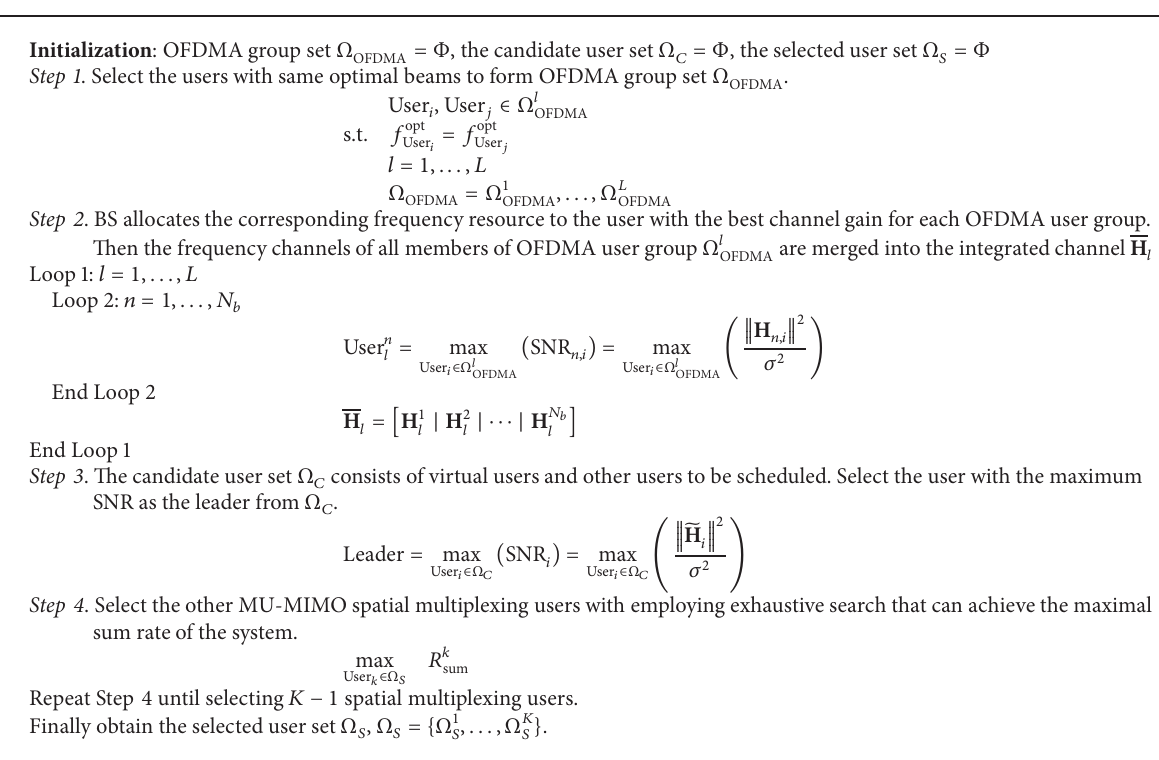
Algorithm 1: User scheduling